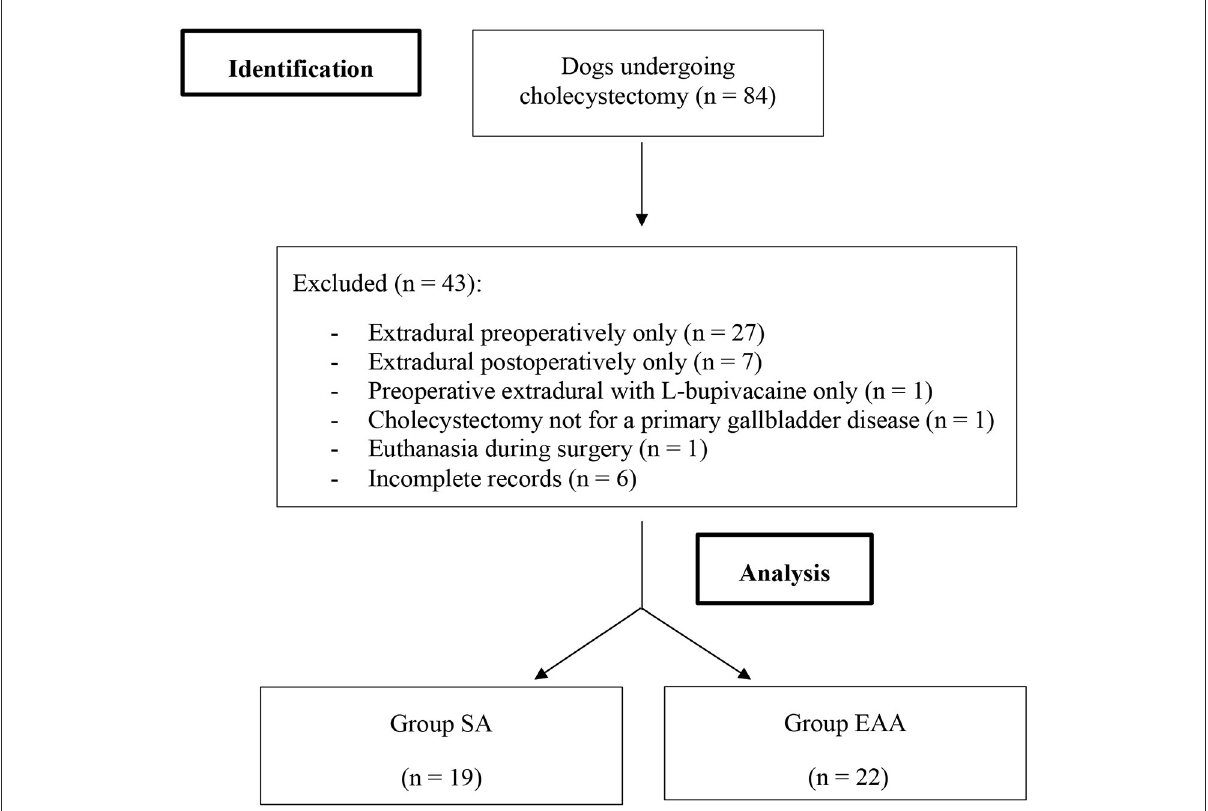
FIGURE1 Consolidated Standards of Reporting Trials (CONSORT) flow diagram. n, number; SA, systemic analgesia; EAA, extradural anaesthesia-analgesia.